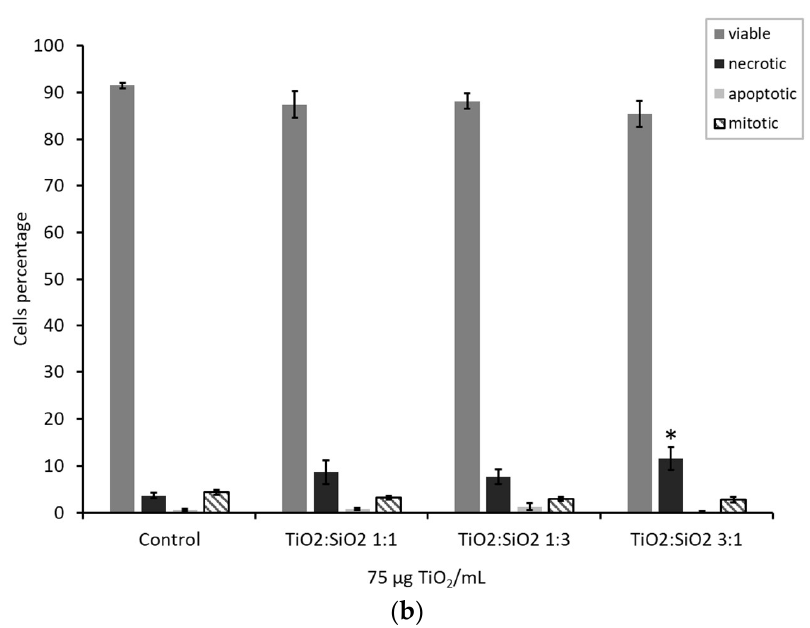
Figure 4. ( a ) Cell viability was assessed by MTT test after 24 h of exposure to increasing doses of different TiO 2 :SiO 2 NPs. The white histogram represents control sample, dark grey bars represent dose 750 μg TiO 2 /mL, grey bar dose 75 μg TiO 2 /mL, and light grey bars dose 7.5 μg TiO 2 /mL. Data show the mean ± SE of at least three independent experiments. * Statistically significant with respect to control, p < 0.001; # Statistically different with respect to TiO 2 :SiO 2 1:1 at dose 750 μg TiO 2 /mL, p < 0.001; § Statistically different with respect to TiO 2 :SiO 2 1:3 at dose 750 μg TiO 2 /mL, p = 0.006. One-way ANOVA + Bonferroni’s post hoc test. ( b ) Hoechst 33342/propidium iodide (H/PI) staining of A549 treated for 24 h with different TiO 2 :SiO 2 NPs (75 μg TiO 2 /mL). The histograms represent the percentage of viable (grey bars), necrotic (black bars), apoptotic (light grey bars), and mitotic (dashed bars) cells. Data show the mean ± SE of at least three independent experiments. * Statistically significant with respect to control according to one-way ANOVA + Bonferroni’s post hoc test; p < 0.05.